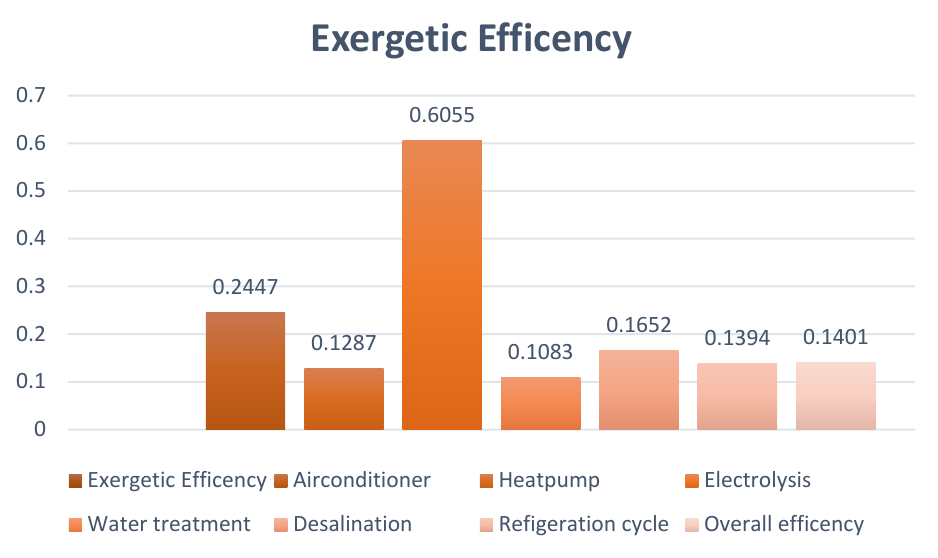
Figure 16. Exergy efficiency of different components.